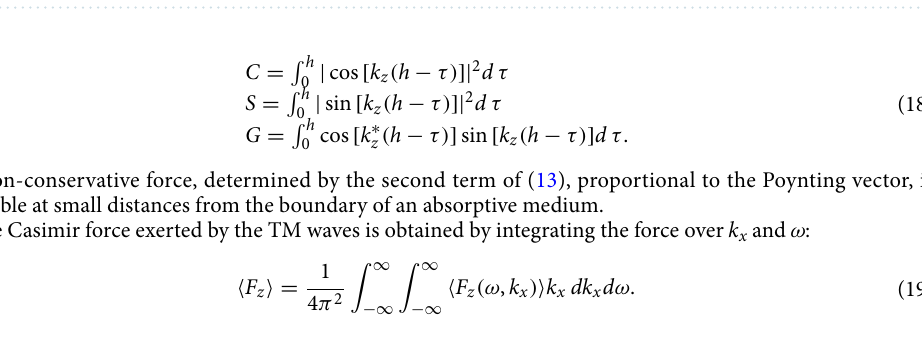
) (red solid line), and 1 / (cid:31)